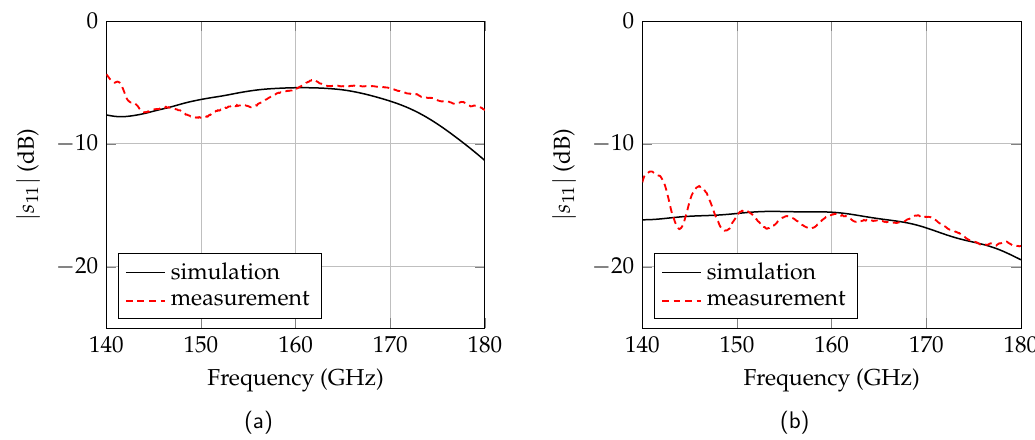
Figure 7. Simulated and measured reflection coefficients of the metal cuboids ( a ) and the metal cylinders ( b ).